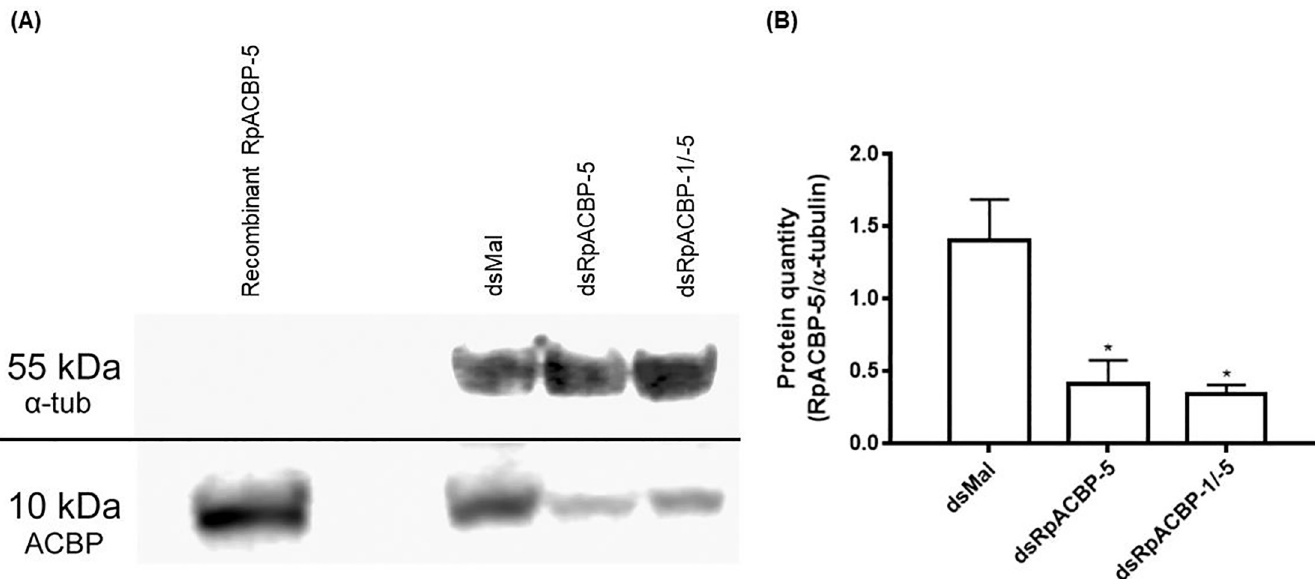
Fig 8. RpACBP-5 protein content in the posterior midgut after knockdown by RNAi. Fasted adult females were injected with 1 μ g of dsRpACBP-5, or with a mixture of dsRNAs containing 1 μ g of dsRpACBP-1 and 1 μ g of dsRpACBP-5, or with two μ g of dsMal, used as control. Insects were fed three days after injection, and the posterior midgut was collected on the seventh day after feeding. (A) Samples (60 μ g protein) were subjected to Western blotting, with anti-RpACBP-5 antiserum or anti- α -tubulin antibody. The image is representative of three experiments. (B) The intensity of the bands was estimated by densitometry. The bars are means ± SEM. ( � ): significantly different from dsMal by one-way ANOVA, followed by Dunnett’s post-test with p < 0.05; n = 2–3.